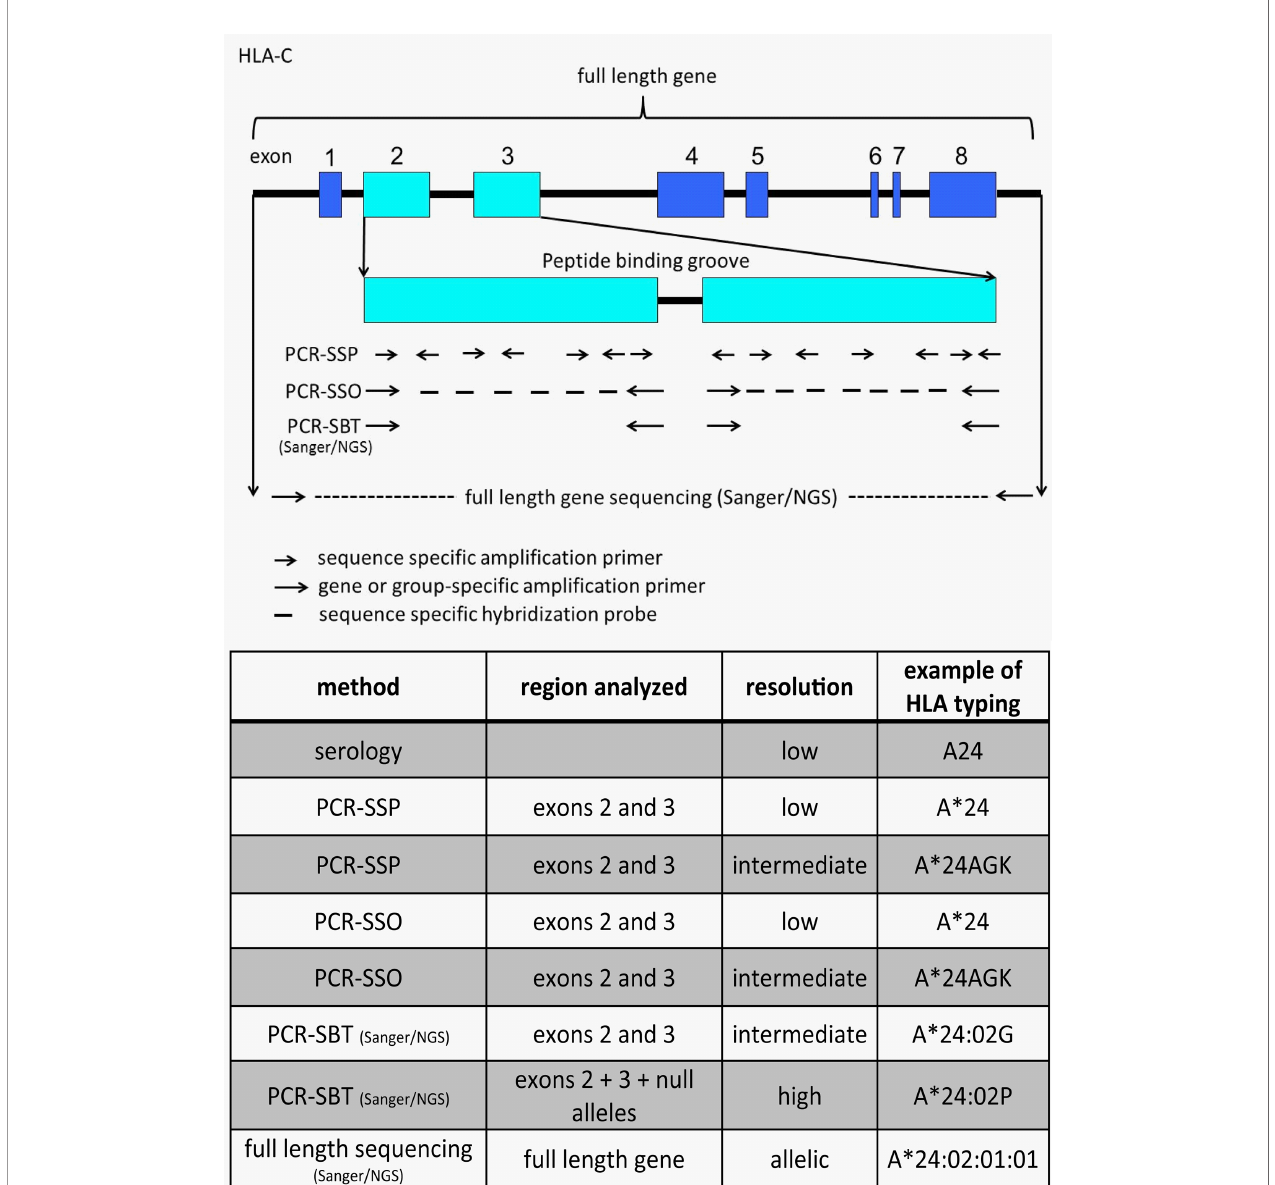
FIGURE 4 | Illustration and comparison of different HLA typing methods and the generally obtained typing resolution level. The fi gure depicts HLA-C as an example. Depending on the number of sequence speci fi c primers or probes the PCR-SSP/SSO method can have low or intermediate resolution typing result. A*24AGK: string of different A*24 alleles. A*24:02G: group of alleles with identical peptide binding groove, but differences outside (including null alleles). A*24:02P: group of proteins with identical peptide binding groove, but differences outside (excluding null